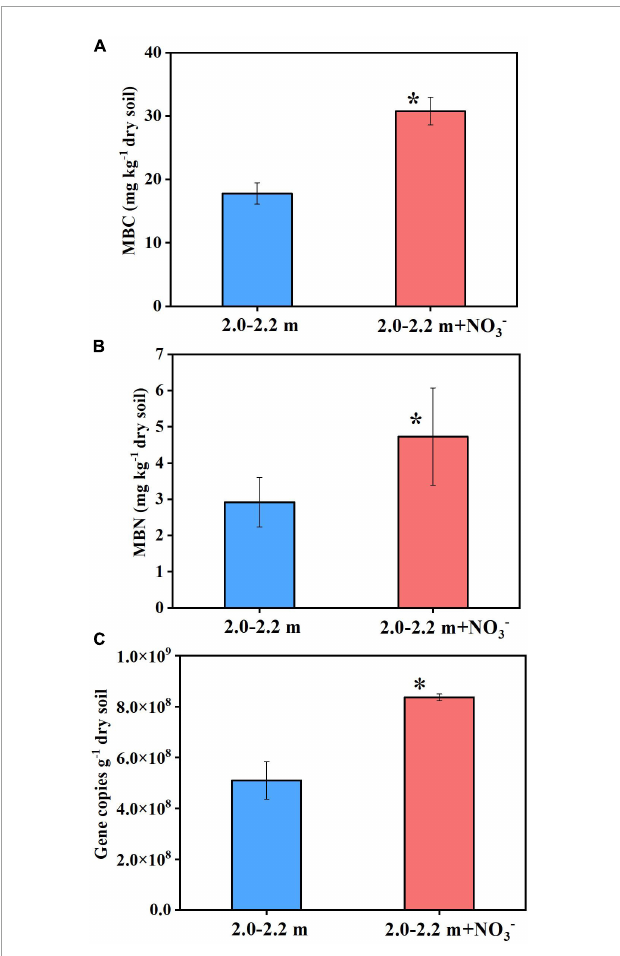
FIGURE4 Nitrate addition effects on the MBC (A) , MBN (B) , and 16S DNA gene copies (C) in deep soil after 98 days at the end of Experiment 5. Data are shown as the mean ± standard deviation ( n = 3). Asterisk denotes significant difference ( P < 0.05) between the two